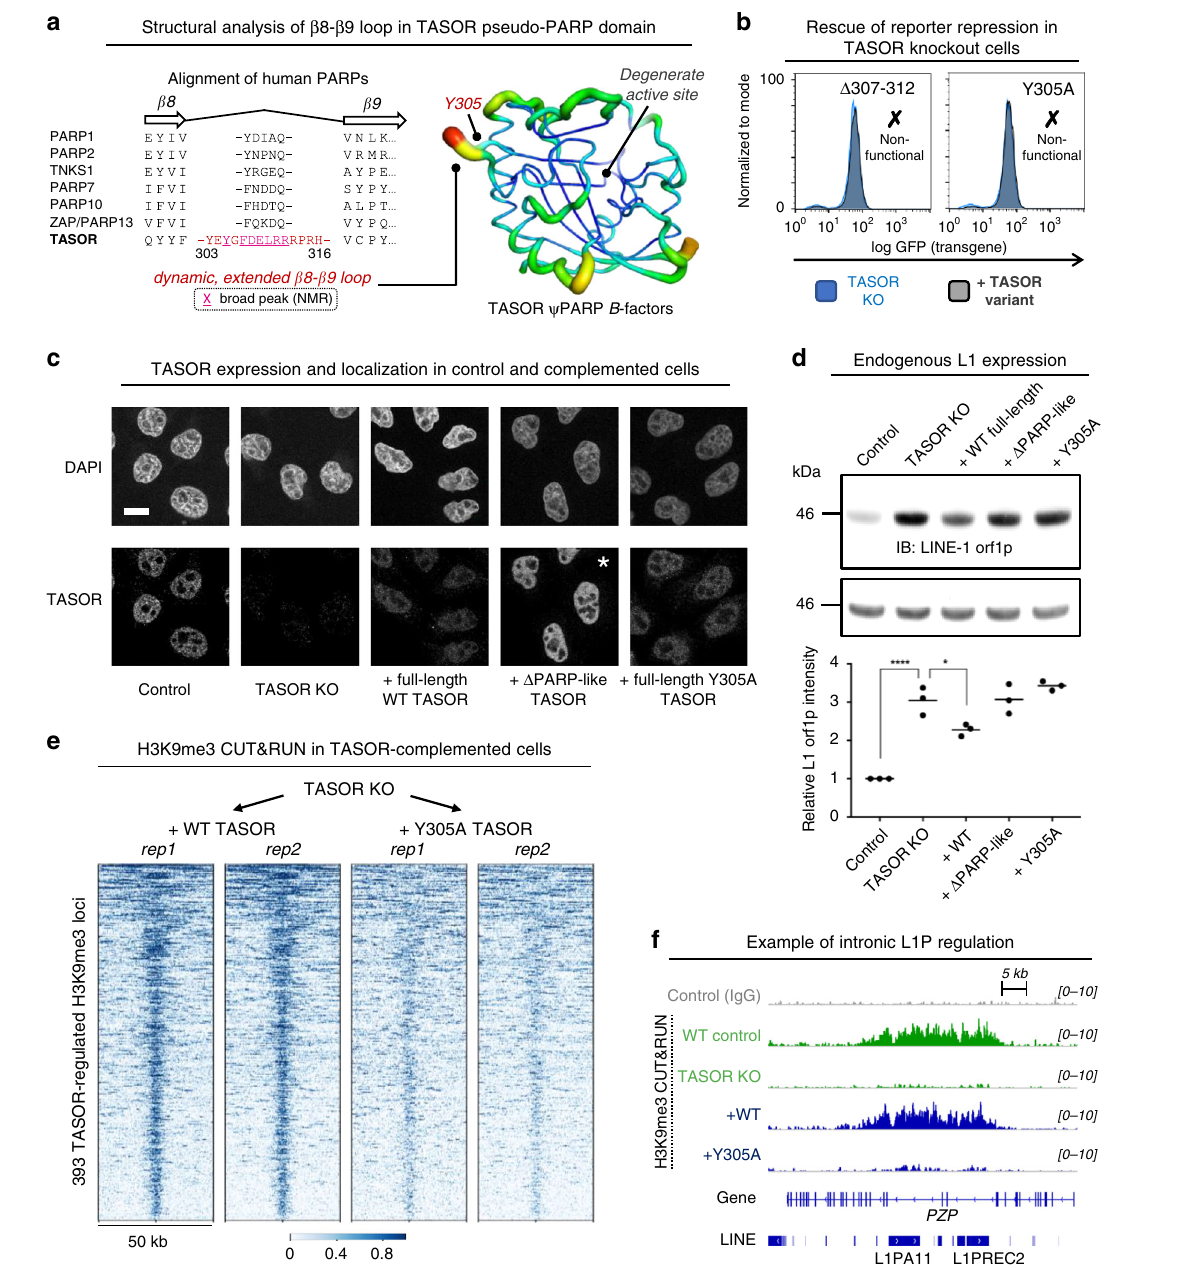
Fig. 6 Structure-guided TASOR mutation abrogates HUSH repression, L1 restriction and H3K9me3 deposition. a Alignment of human PARP catalytic domains, focused on the connecting loop between the fi nal two beta-strands. TASOR residues whose signals are broadened by fast T2 relaxation in NMR spectra are underlined. (left). Structure of TASOR pseudo-PARP domain colored by B-factor with features marked (right). b Δ 307 – 312 or Y305A mutations in the β 8 – β 9 extended loop of TASOR cause loss of GFP transgene repression. c Confocal immuno fl uorescence of TASOR localization in nuclei of indicated cell lines. Scale bar, 15 µ m. Asterisk is shown for TASOR in Δ PARP cells; the expression was higher for this construct so brightness was adjusted to avoid saturation. d TASOR KO causes derepression of LINE-1 orf1 expression. Repression is partly rescued by full-length WT TASOR but not TASOR Δ PARP nor Y305A. * P < 0.05; **** P < 10 − 4 that KO and control or complemented cell lines are the same ( n = 3, one-way ANOVA, measurements taken from distinct samples). Source data are provided in the Source data fi le ( “ L1 Westerns ” tab). e CUT&RUN heatmaps showing H3K9me3 levels in TASOR KO cells complemented with either wild-type or Y305A TASOR. The Y305A mutation causes loss of H3K9me3 at the 393 TASOR-regulated loci identi fi ed in Fig. 1. f Genome browser snapshot of CUT&RUN data showing rescue of H3K9me3 over two intronic L1P elements in PZP in the presence of WT but not Y305A